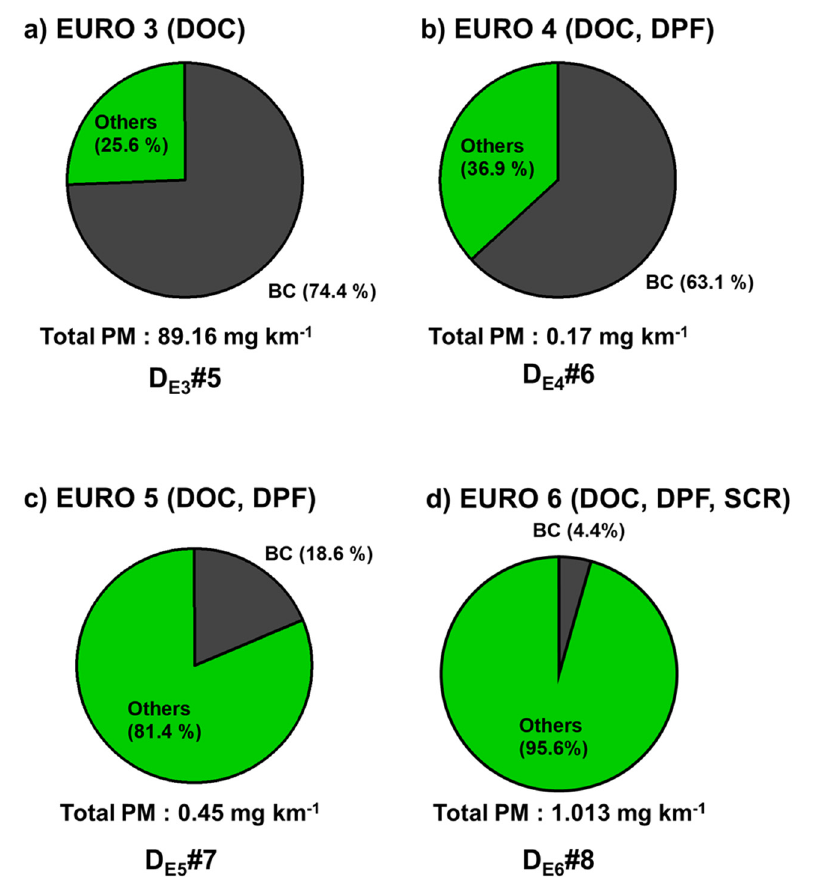
Figure 9. BC / PM ratio of diesel vehicles from EURO 3 to EURO 6. ( a ) EURO 3 vehicle with DOC for aftertreatment. ( b ) EURO 4 vehicle with DOC and DPF. ( c ) EURO 5 vehicle with DOC and DPF. ( d ) EURO 6 vehicles with DOC, DPF, and SCR.